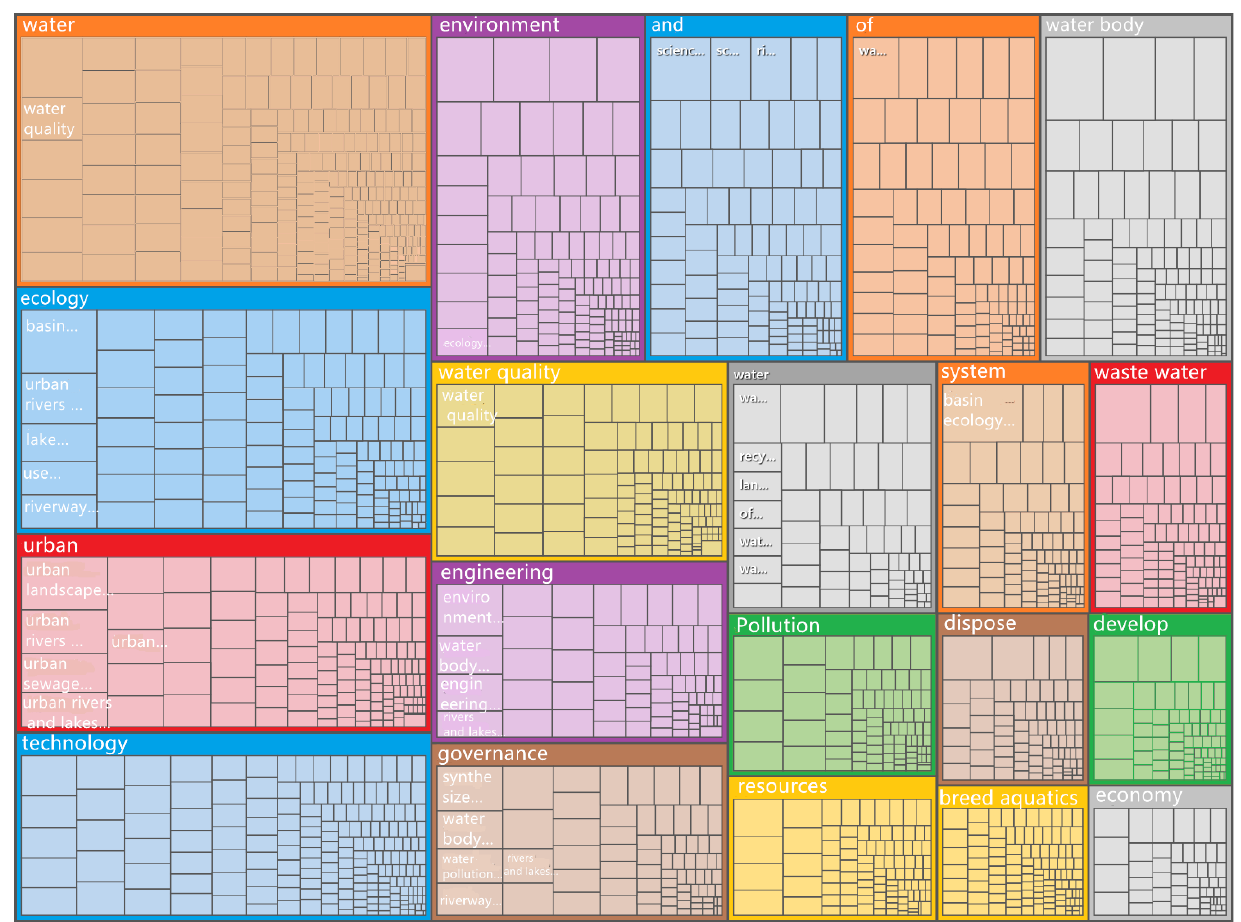
Figure 16. Hierarchical diagram of automatically coded topic nodes and reference points from CNKI. Table 8. Summary of topic nodes and reference points of CNKI automatic coding.